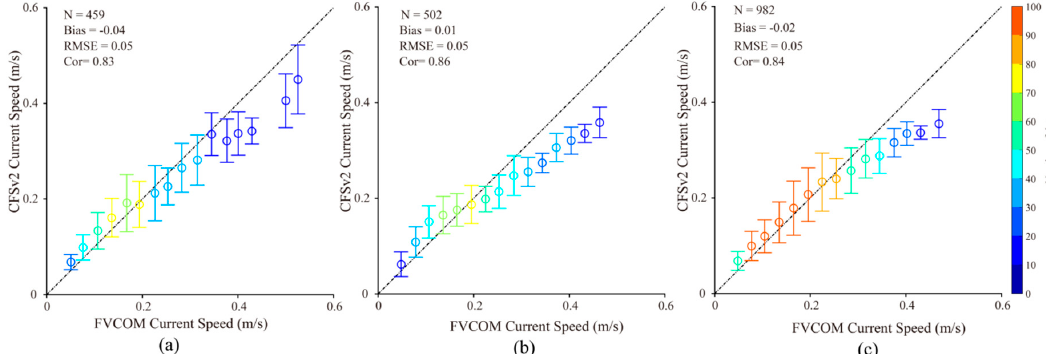
Figure 8. Comparison between current speeds simulated by the FVCOM and the CFSv2 data for a 0.1-m / s bin between 0 and 0.6 m, in which the error bars represent the standard deviations of each bin for the matchups in (a) Region A, (b) Region B, and (c) Region C.